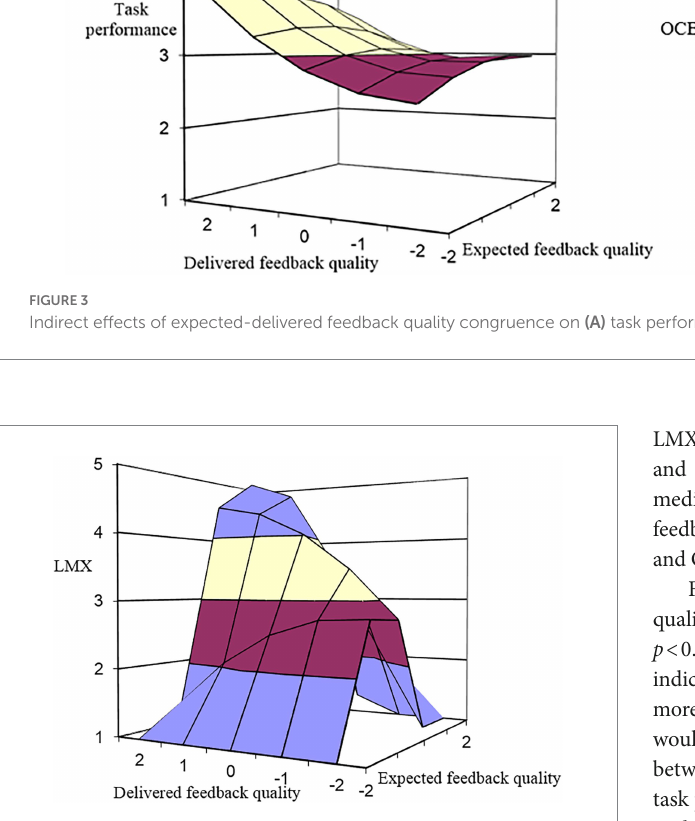
FIGURE 4 Direct effect of expected-delivered feedback quality congruence on LMX at a high level of learning goal